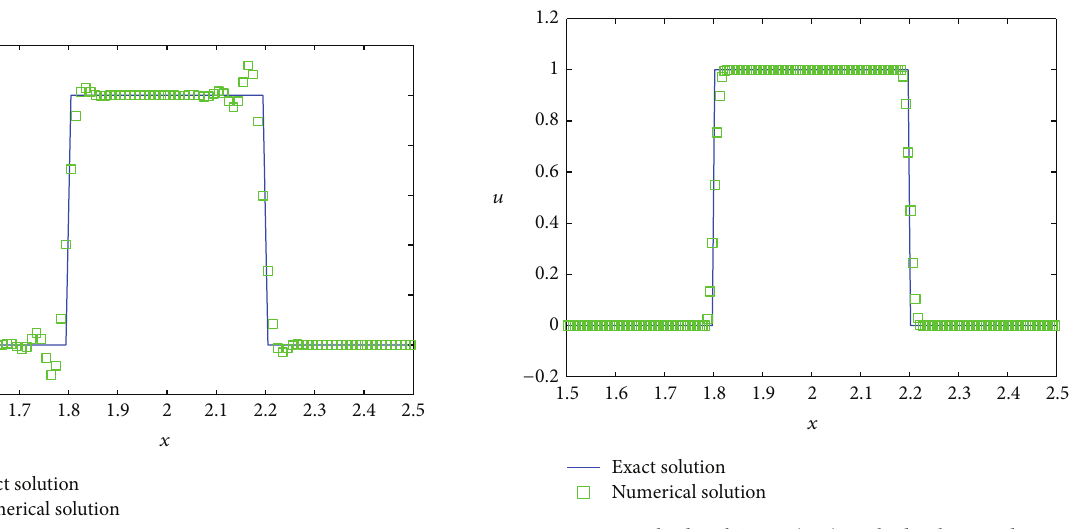
Figure 2: SHA method applied to linear advection equation for a square wave; numerical (symbols) and exact (line) solutions are compared at 𝑡 = 2 units.